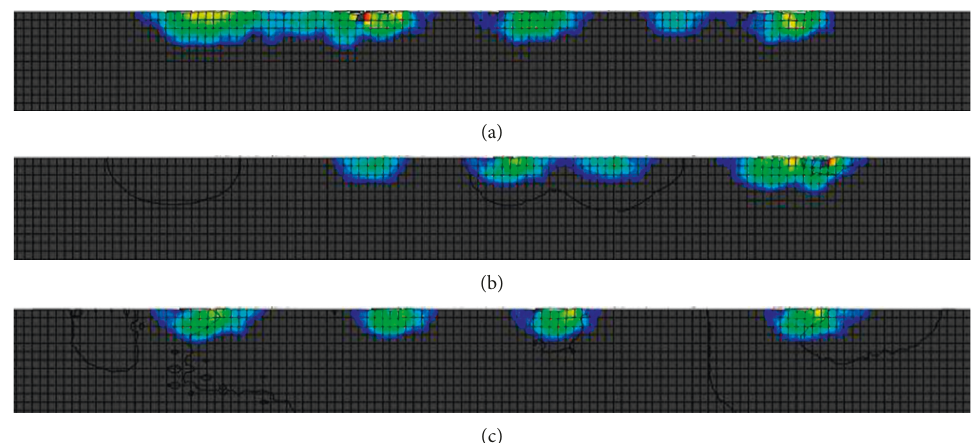
Figure 19: Stress contour result after filtering ( > 258 MPa) on ZX plane cross section: (a) Y � − 110 μ m, (b) Y � − 60 μ m, and (c) Y � 0 μ